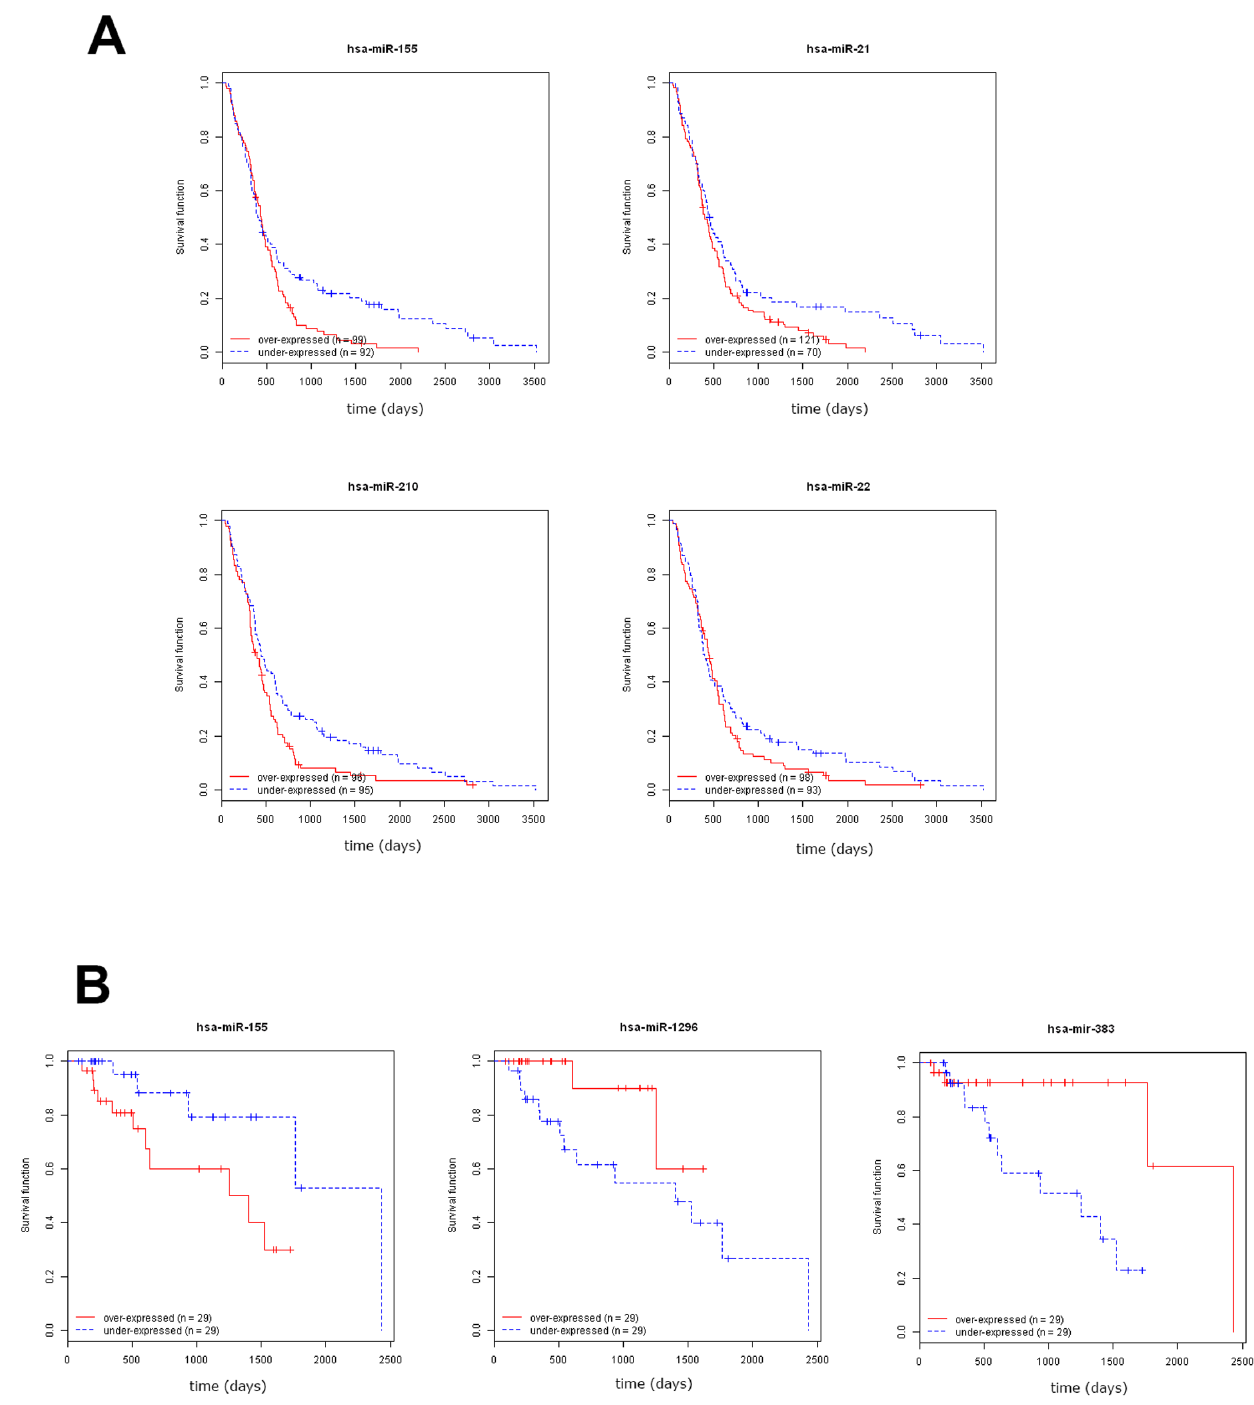
Figure 3. Relationship between miRNAs expression and survival in glioma patients. A) Kaplan-Meier curves showing the relationship of miR-155, miR-21, miR-210 and miR-22 with Overall Survival in patients from the GBM dataset. B) Kaplan- Meier curves showing the relationship of miR-155, miR-1296, and miR-383 with Overall Survival in Grade III glioma patients from the LGG dataset.